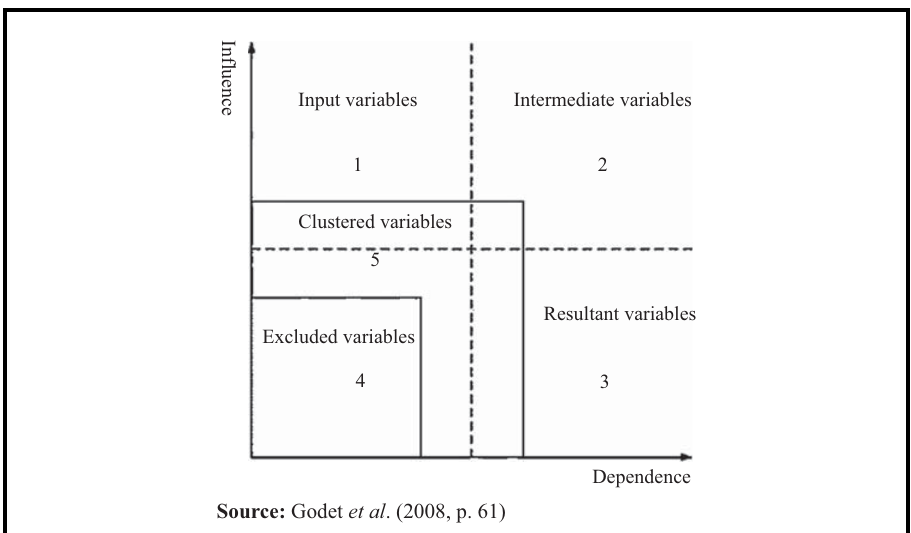
Figure 1 Different types of variables on the matrix with axes influence and